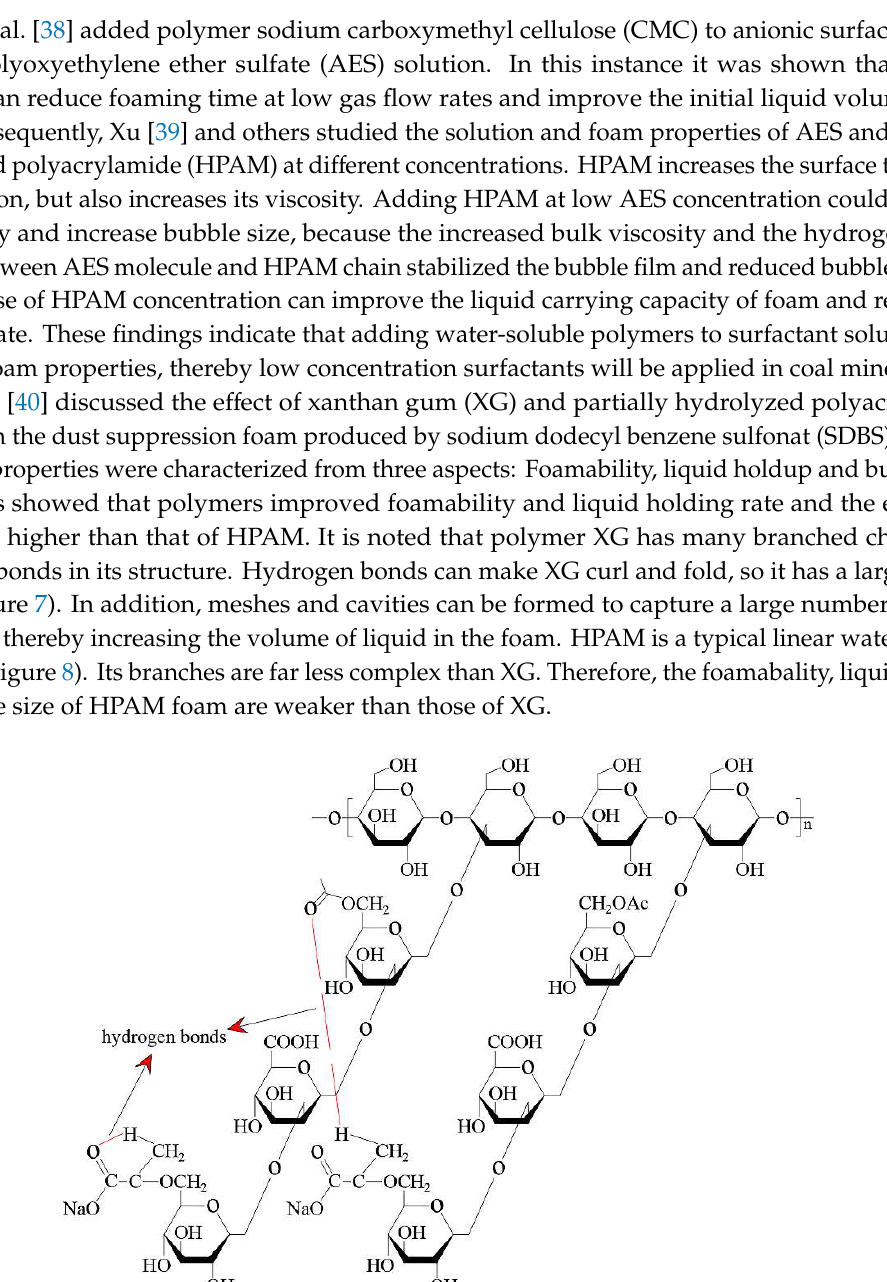
Figure 6. Foam drainage behavior of the surfactant solution with added polymer [37].